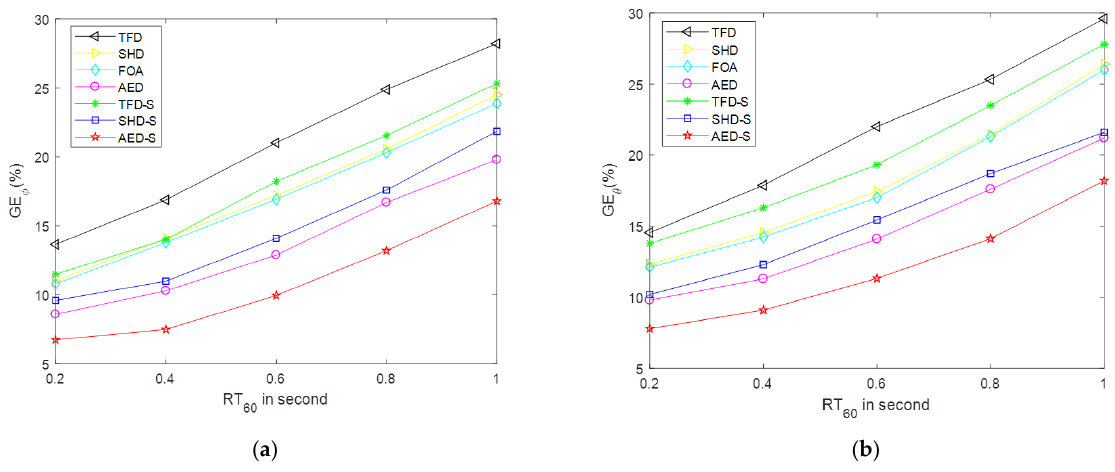
RT with the threshold 20 = . ( a ) is the GE for azimuth Figure 7. GE for estimation against Figure 7. GE for estimation against RT 60 with the threshold λ = 20. ( a ) is the GE for azimuth against 60 RT . ( b ) is the GE for elevation against RT . against RT 60 . ( b ) is the GE for elevation against RT 60 60 60